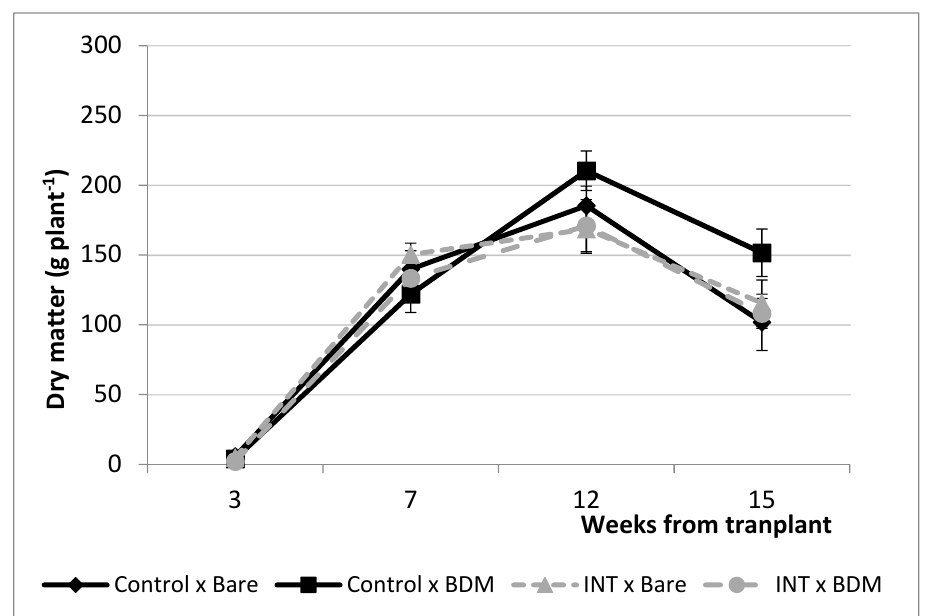
Figure 3. Dry matter accumulation in stems and leaves biomass of tomato cv Kendras during the 2018 crop cycle. Legend: vertical bars represent error standard of mean (N = 10) per each combination of treatments in different sampling times. Control × Bare: standard farm fertilization × Bare soil; Control × BDM: standard farm fertilization × Biodegradable mulch; INT × Bare: solid digestate integrated with mineral fertilizers × Bare soil; INT × BDM: solid digestate integrated with mineral fertilizers × Biodegradable mulch.